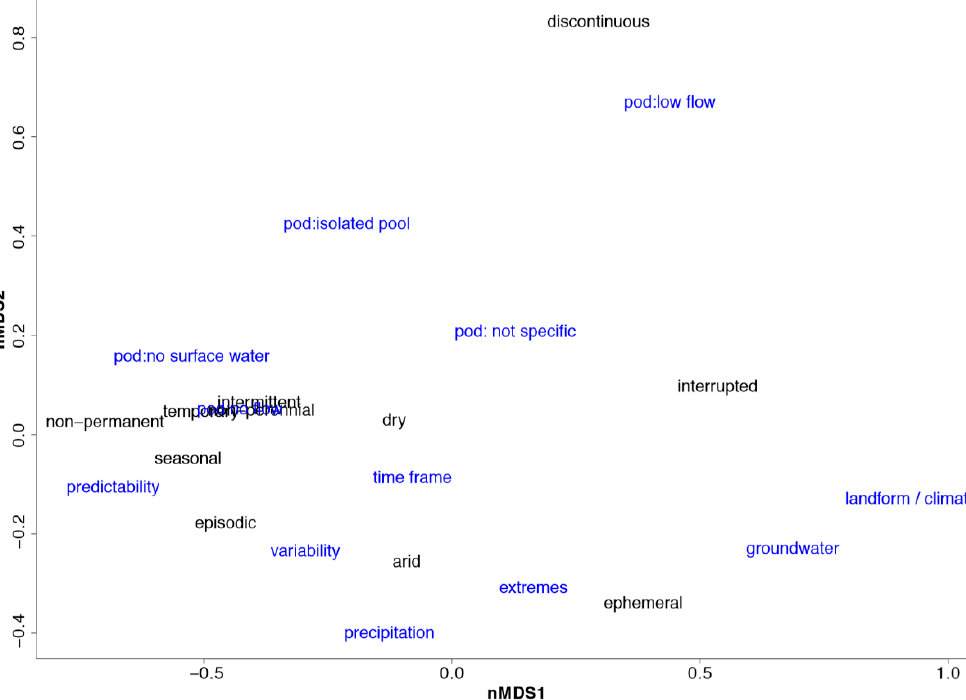
Figure 5. An nMDS representing the Euclidean distance among epithets and definition themes (stress = 0.0962). Epithets in blue text, definition themes in larger, black text. The section of the nMDS with overlap includes epithets “intermittent”, “temporary”, and “non-perennial” as well as the theme Phases of Drying: No Flow. Full theme list: predictability = predictability/seasonality; variability = variability/unpredictability; time frame = specific time frame mentioned; landform/climate = related to specific landform/climate; extremes = related to extremes (droughts and floods); pod = phases of drying: (Table S2).